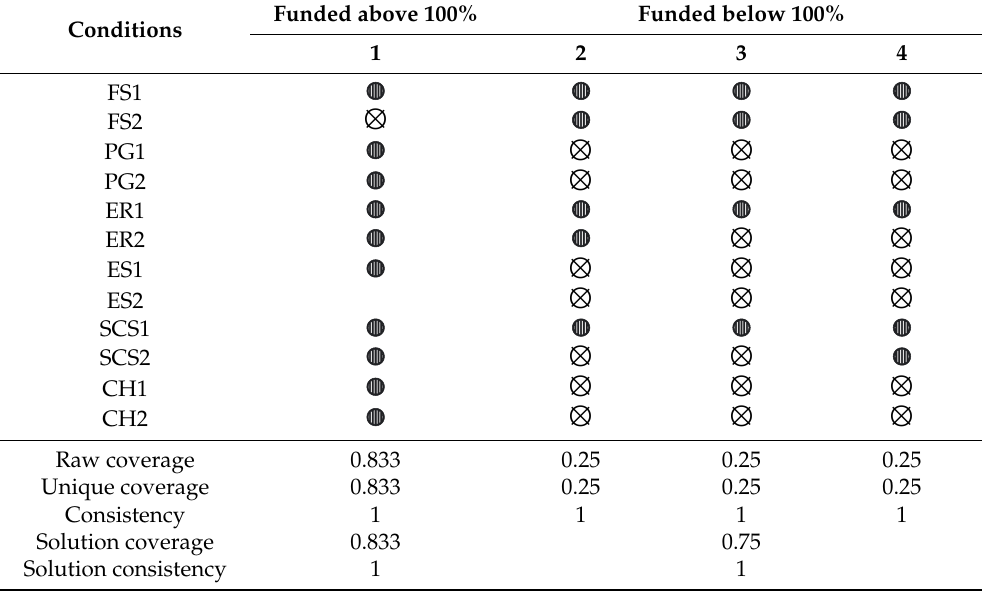
Table 3. Analysis of sufficient conditions: the intermediate solution. Black circles ( care” condition. Please note that a detailed description of the meaning of the variables is available in Table